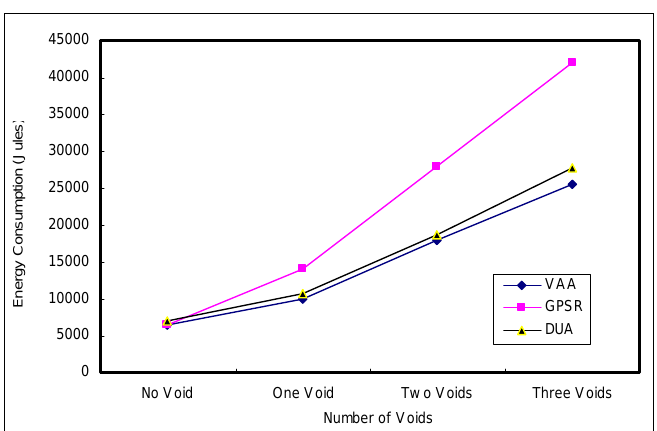
Figure 22. Energy consumption.